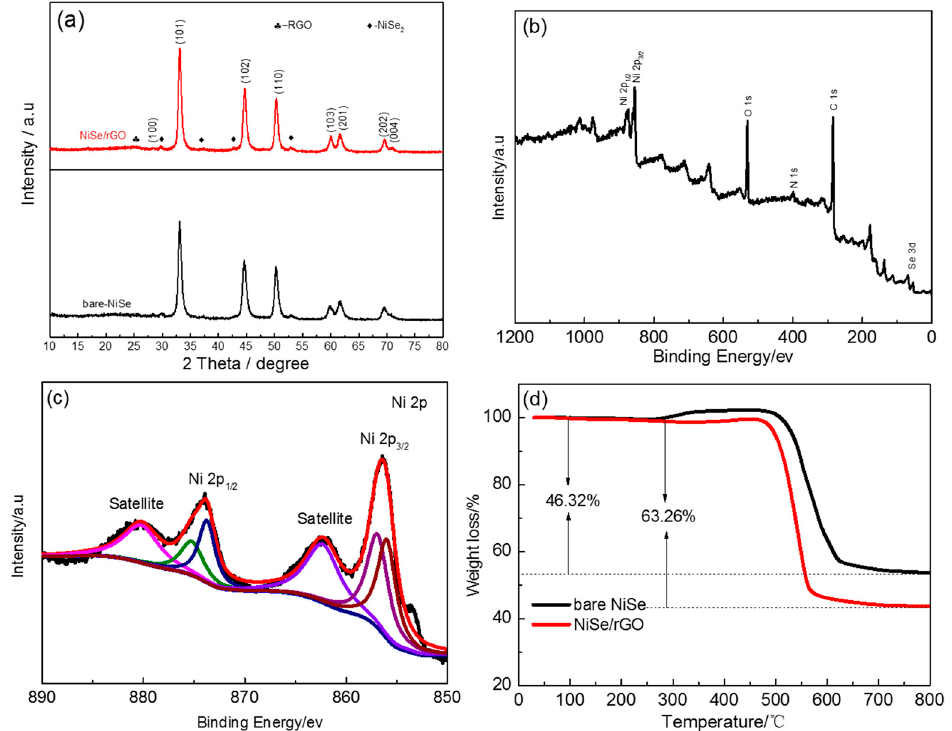
Figure 1. ( a ) X-ray di ff raction (XRD) patterns of bare NiSe and NiSe / rGO composite. ( b ) X-ray photoelectron spectroscopy (XPS) survey and ( c ) high-resolution Ni 2p spectra of Nickel selenide (NiSe) / reduced graphene oxide nanosheets (rGO) composite. ( d ) thermogravimetric (TG) curves of the bare NiSe and NiSe / rGO.